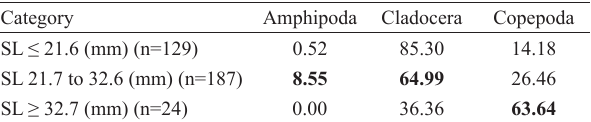
Table 4. Diversity and anual volume of microcrustations